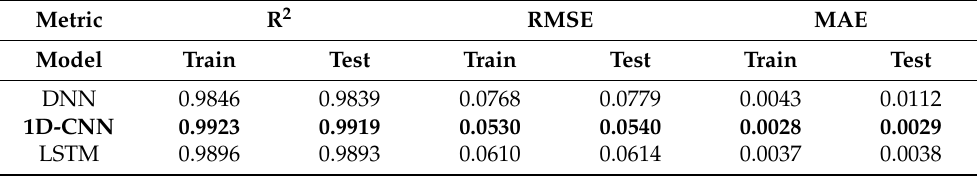
Table 6. A performance comparison of prediction models for valve seating velocity prediction.